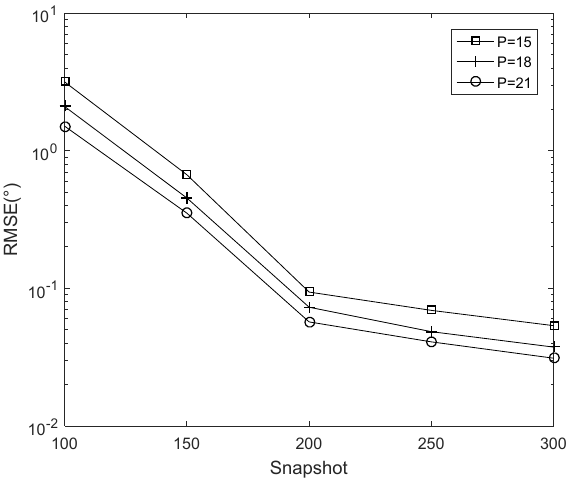
θ versus the number of snapshots. Figure 11. RMSE performance of